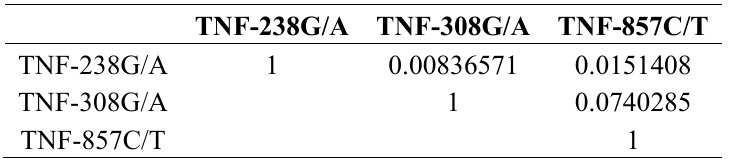
Table 2. Results of linkage disequilibrium statistics for TNF-alpha polymorphisms for Romanian psoriatic arthritis (PsA) patients and controls.